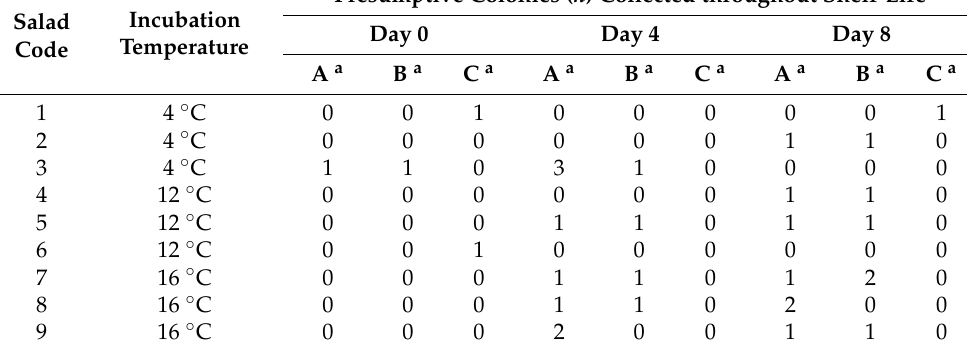
a —different capital letters represent experimental replicates (different salad production